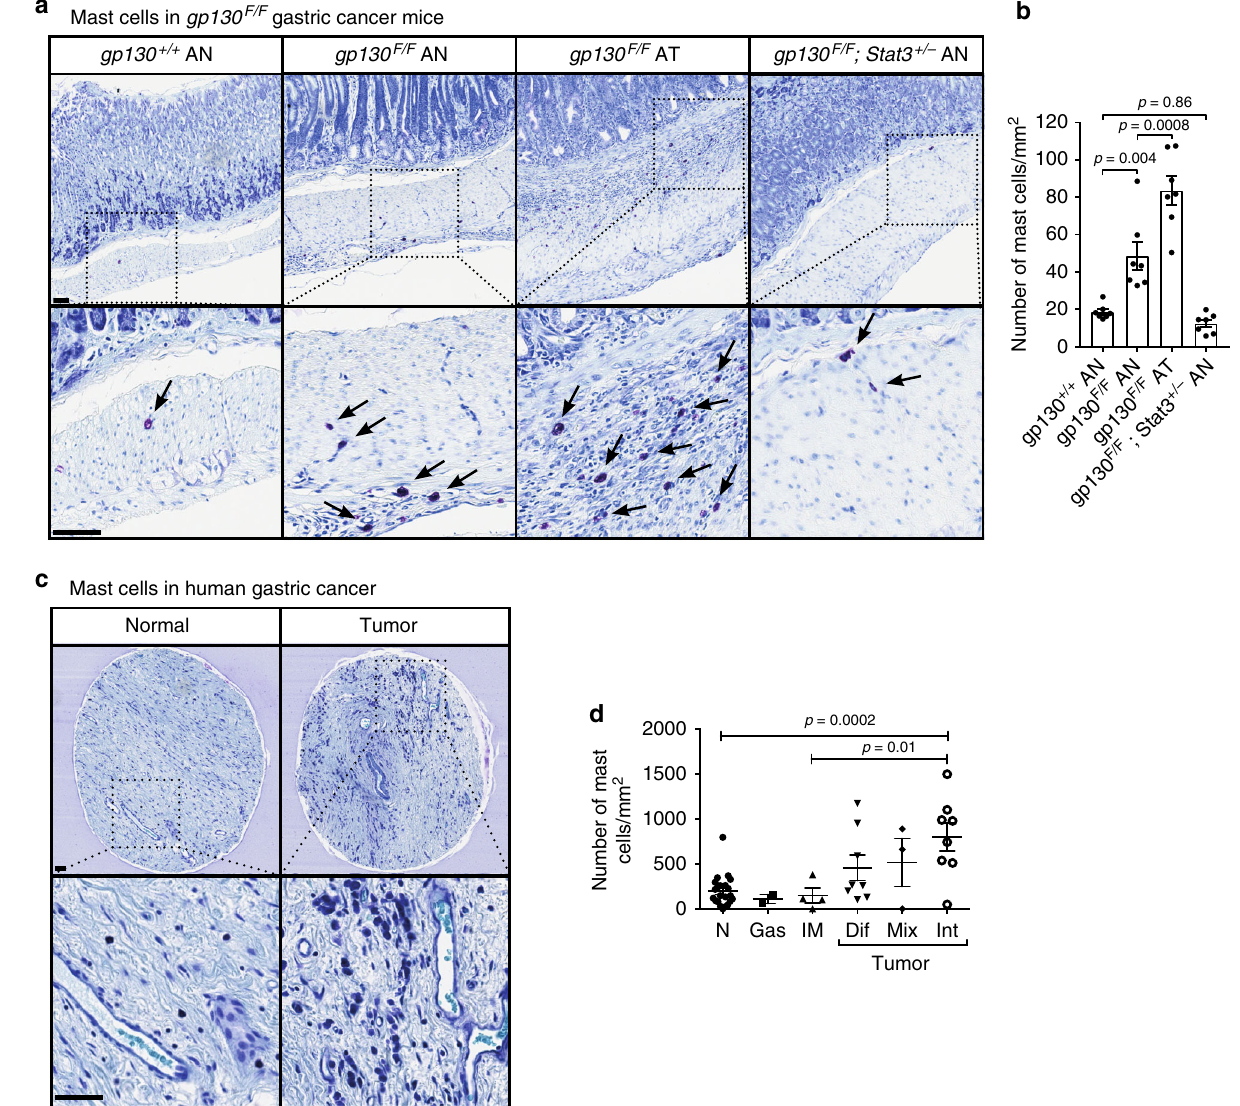
Fig. 1 Submucosal mast cell numbers are increased in gastric cancer in mice and humans. a Representative cross sections of stomachs of 100 day old gp130 mutant mice of the indicated genotype and stained with toluidine blue showing the affected antrum (AN) and antral tumor (AT), respectively. Mast cells appear purple (arrows). Scale bars = 50 µ m. b Quanti fi cation of submucosal mast cell in sections depicted in ( a ). n = 7 mice per cohort obtained from two independent experiments, one-way ANOVA F (DFn = degree of freedom nominator, Dfd = degree of freedom denominator) = 34.96 (3,